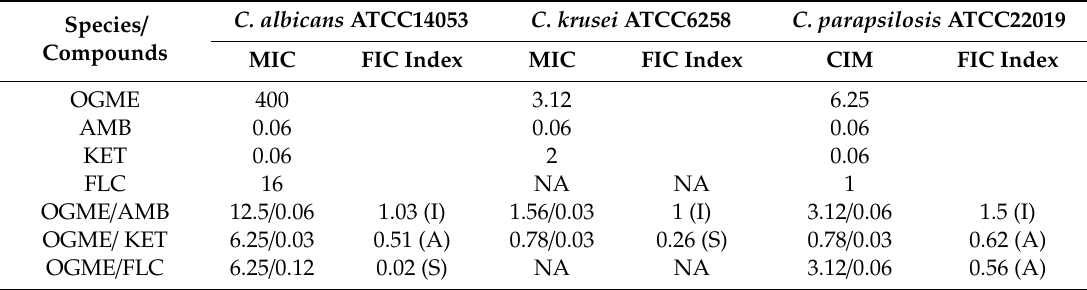
Table 3. MIC ( µ g / mL) and Fractionated Inhibitory Concentration (FIC) indices of antifungal drugs and the e ff ect of their combination with Ocotea glomerata methanol extract.